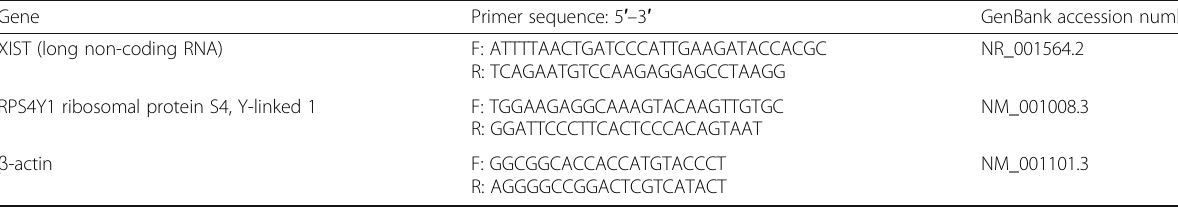
Table 1 Primer sequences specific for each gene Gene Primer sequence: 5 ′– 3 ′ XIST (long non-coding